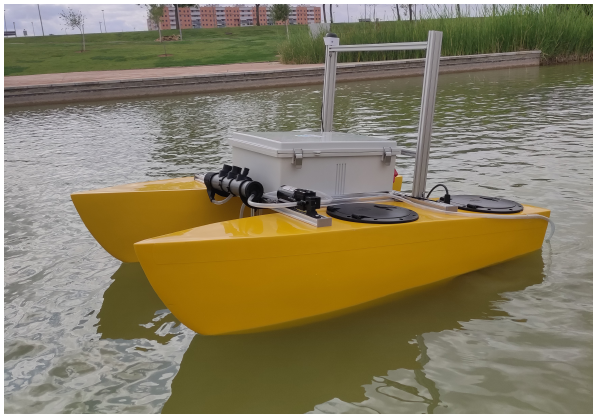
Figure 1. Autonomous surface vehicle using for the monitoring